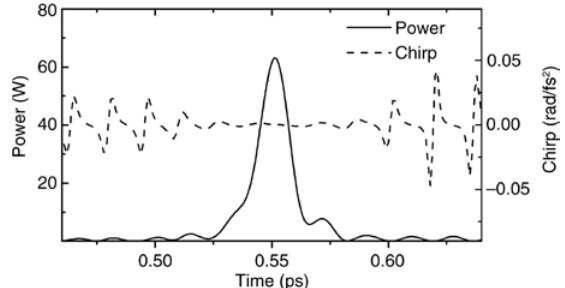
Figure 5: Pulse waveform (solid line) and its frequency chirp (dashed line) in the time domain. The main pulse is slightly chirped. We also show the pulse waveform (solid curve) and frequency chirp (dashed curve) in the time domain in Figure 5. The soliton is slightly chirped at the pulse peak, and the chirp is about 1.5 × 10 −4 rad/fs 2 , which can be caused by the unusual dispersion profile mentioned